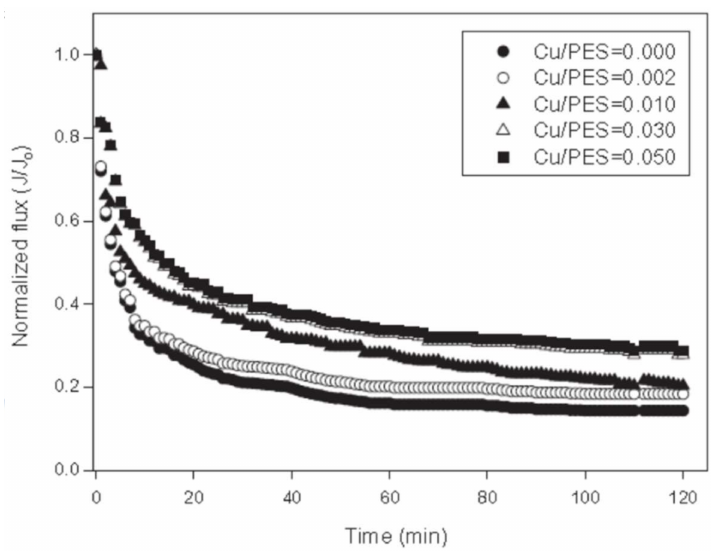
Figure 11. The bio-fouling properties of Cu containing PES composite membranes, adapted from Akar et al. [119].